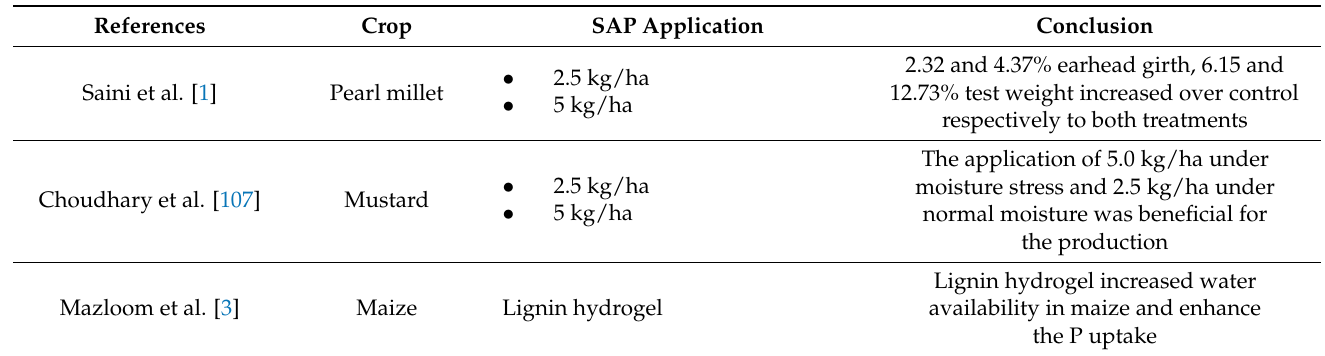
Table 4. Summary of relevant work related to SAP influenced crop growth and